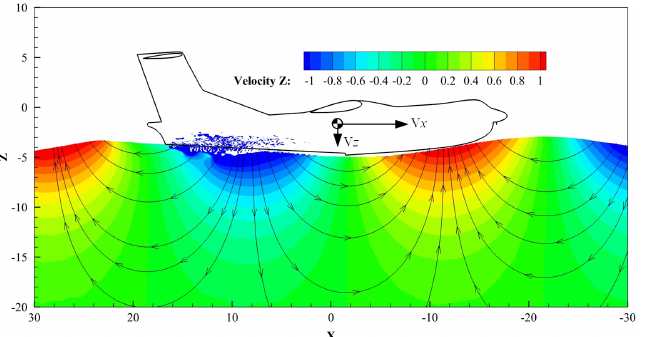
Figure 19. Vertical wave velocity of water field when aircraft landing on wave surface with H = 2 m at t = 0.45